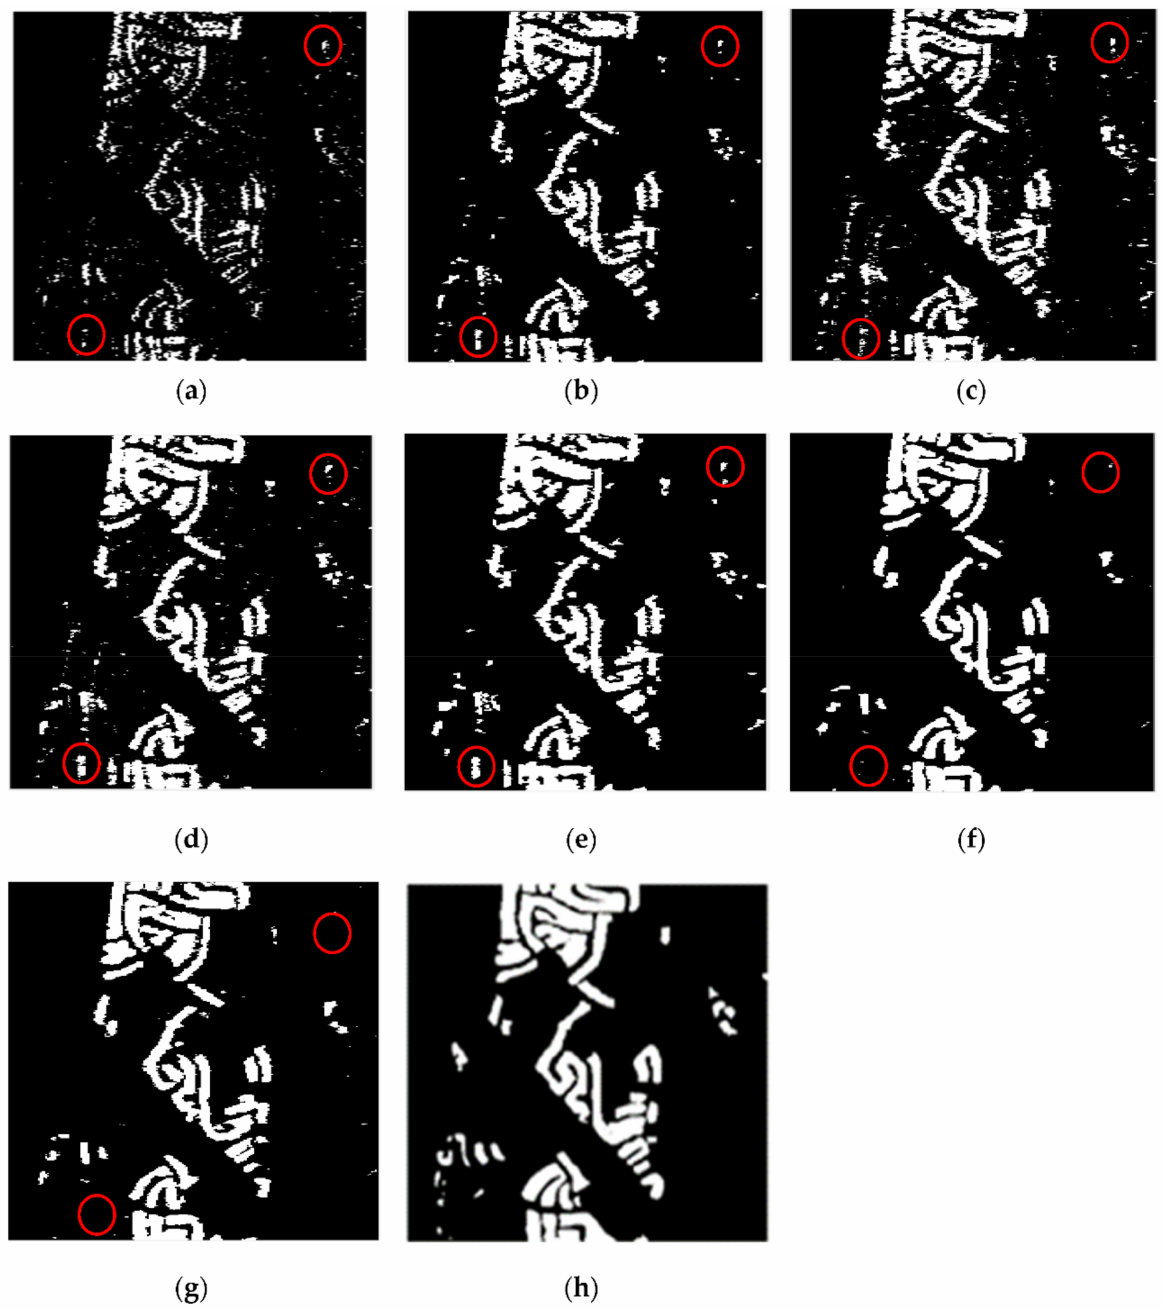
Figure 7. Visualized results of various CD methods on dataset#1; ( a ) PCA_kmeans, ( b ) NR_ELM, ( c ) Gabor_PCANet, ( d ) DP_PCANet, ( e ) CWNN, ( f ) dual-channel deep network, ( g ) TCD-Net, and ( h ) ground truth. The red circles highlight different output performances in no-change